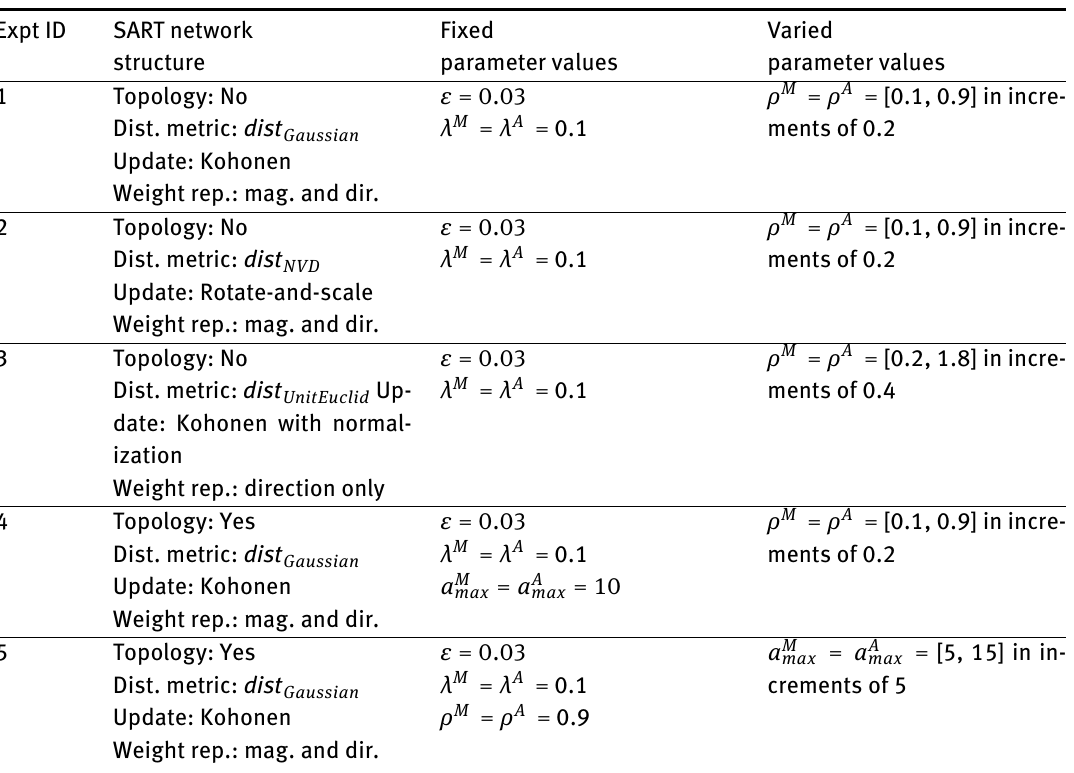
Table 1: Summary of experiments, including fixed and systematically varied parameter